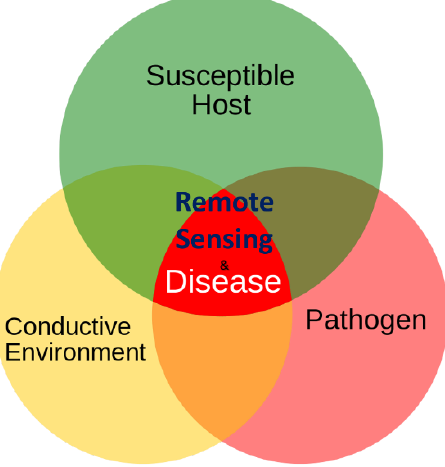
Figure 1. The possible role of remote sensing in the patho-system as represented by the so-called disease triangle.